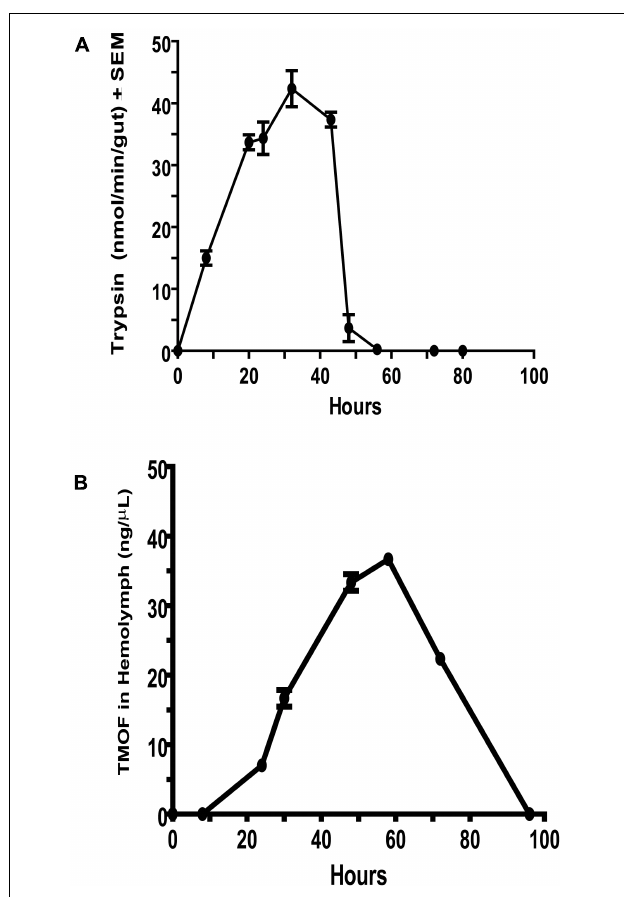
FIGURE 1 | Comparison between Culex quinquefasciatus late trypsin activity in the gut and trypsin modulating oostatic factor (TMOF) concentrations in the hemolymph. (A) Trypsin activity at different times after the blood meal was followed using BApNA in female guts. Activity is expressed as nmol/min/gut, which are then expressed as means of 3 determinations + SEM. (B) The concentration of Aea TMOF in the hemolymph of female mosquitoes was followed at intervals after the blood meal using ELISA. Each concentration represents the mean of 3 determination + SEM.